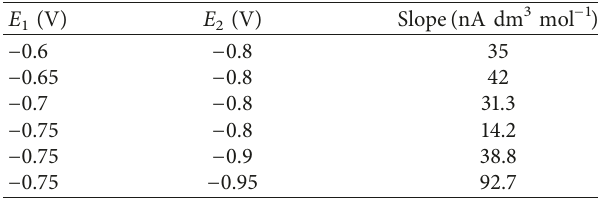
1 and E 2 values for FIA-DPA.